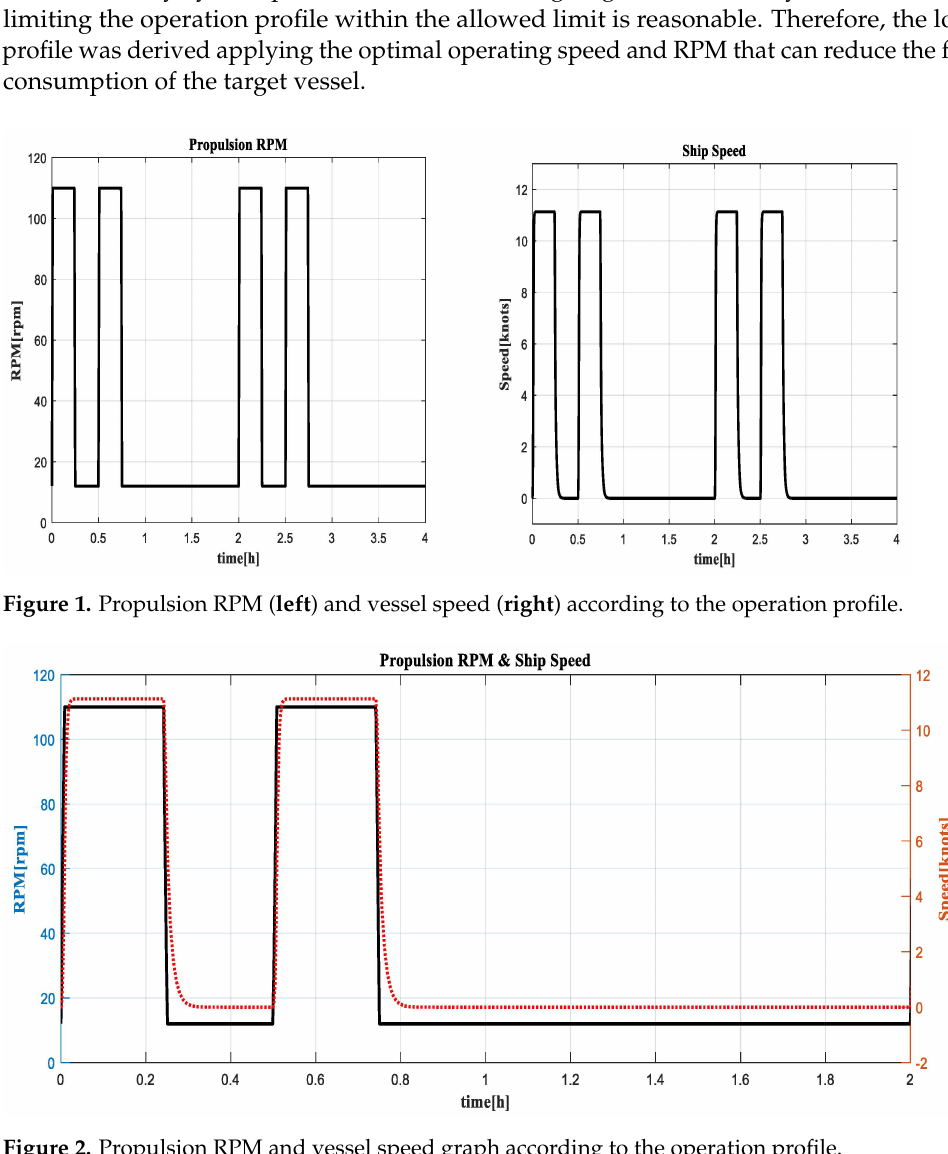
Figure 2. Propulsion RPM and vessel speed graph according to the operation